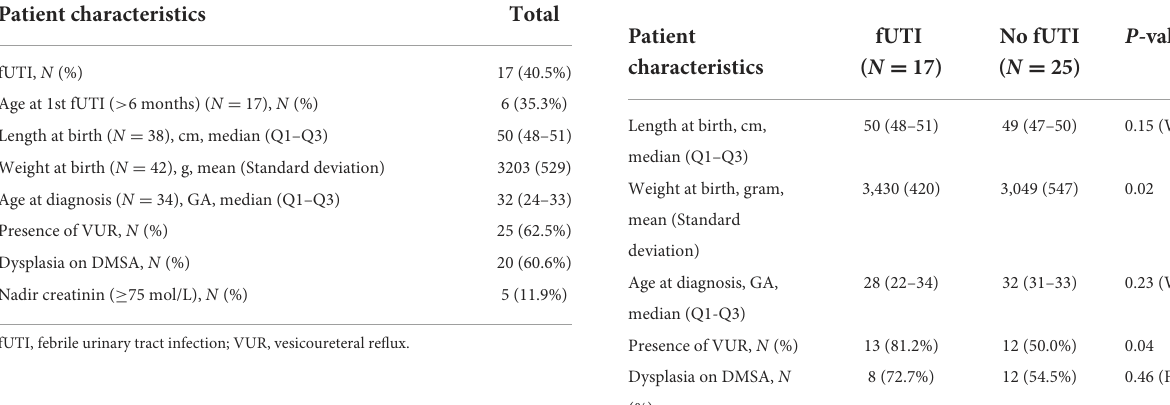
TABLE 1 Patient characteristics ( N = 42).